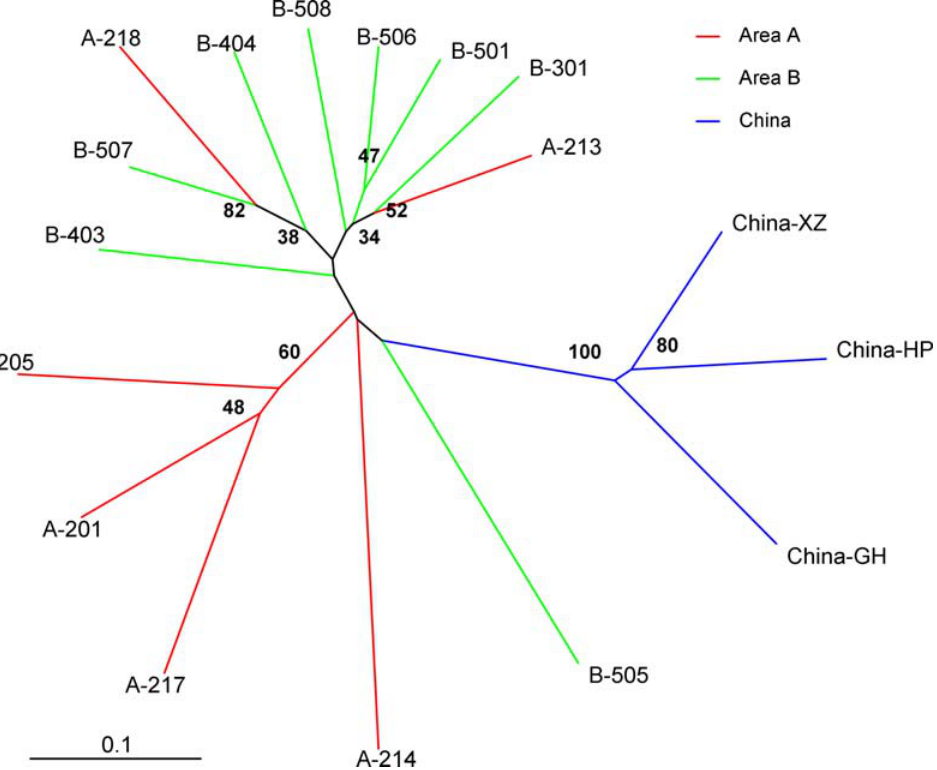
Figure 4. Neighbor-joining tree of Schistosoma japonicum cercariae from 14 villages in two geographic areas of Samar, the Philippines. Cercariae from three villages in Anhui Province, China (GH, Guanghui; HP, Heping; XZ, Xingzhuang) are also displayed. Tree is based on C.S. Chord genetic distances [35] based on 7 microsatellite loci. Geographic area and village codes are indicated at the end of each branch. Bootstrap values (out of 100) are indicated at the branch points. Branches are color coded according to geographic area.